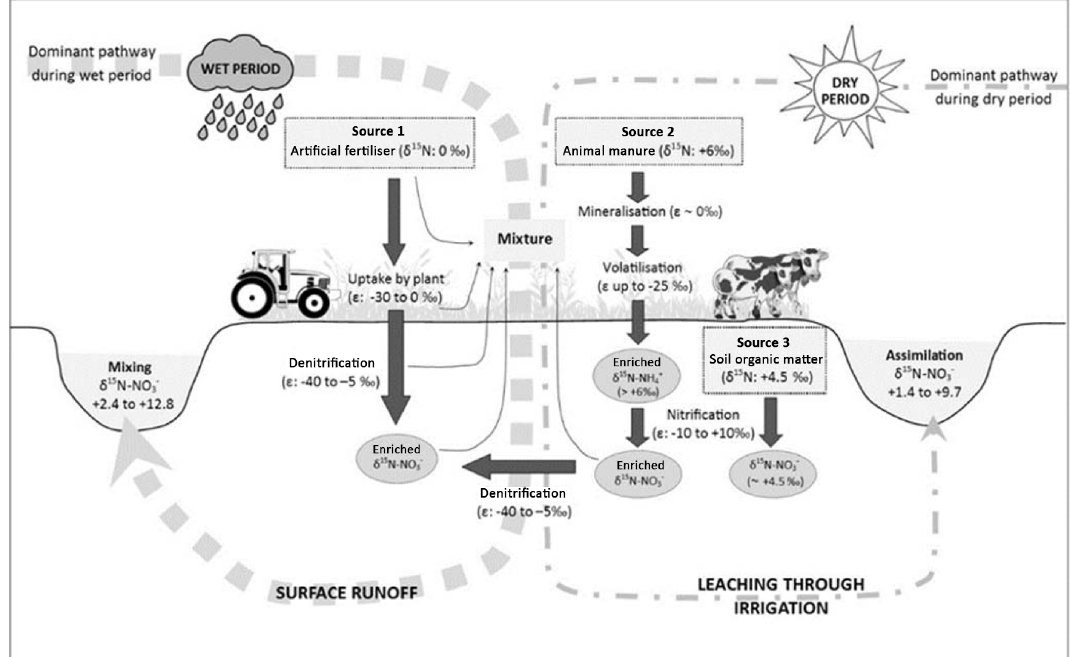
Figure 5. Conceptual diagram illustrating the sources and processes of NO − The values of the enrichment factor ( ε ) were obtained from the literature (Kendall et al., 2007) to indicate the relative contribution of the transformation processes to the isotopic compositions of the residual NO −